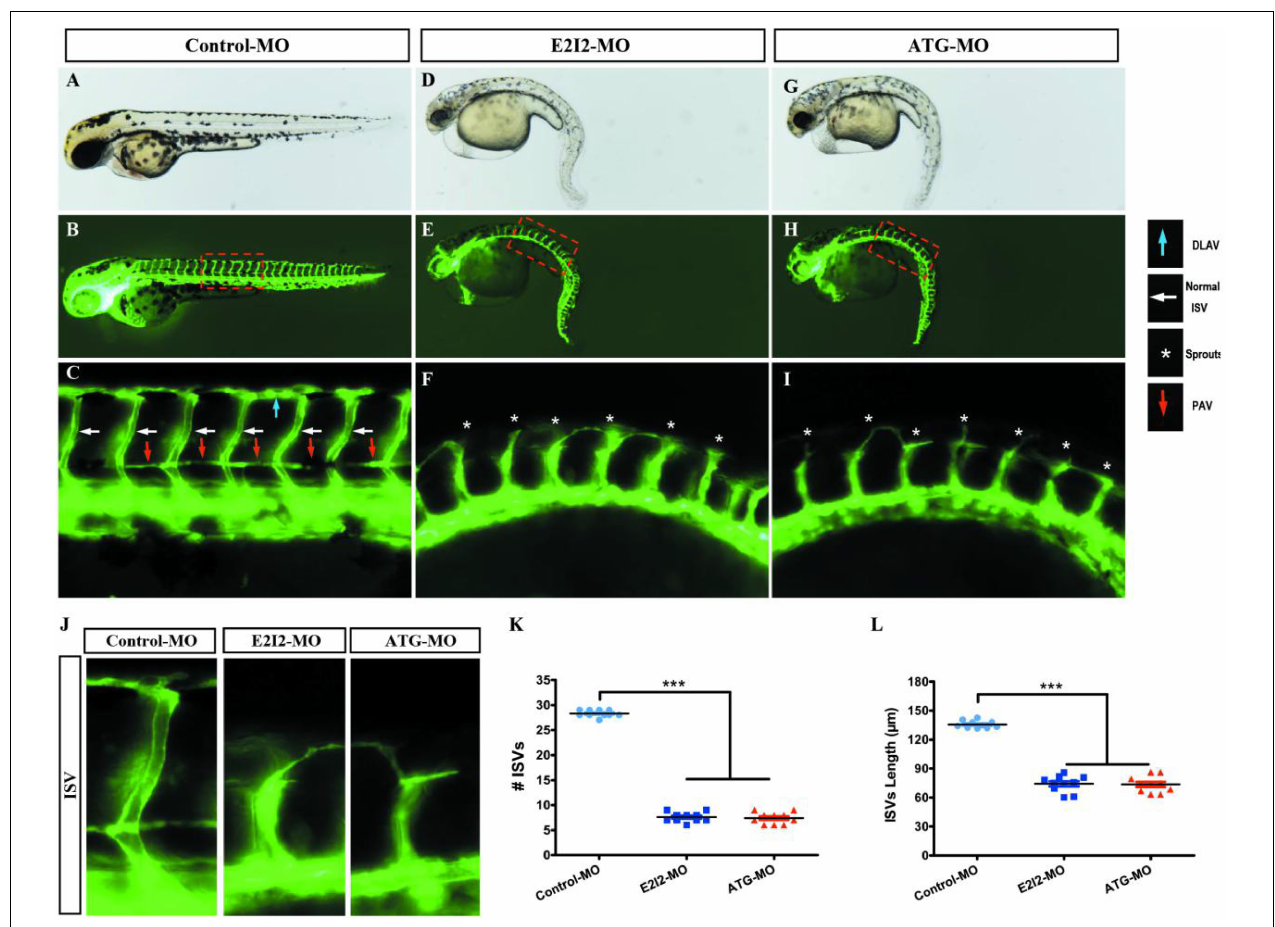
FIGURE 7 | Morpholino knockdown of acta2 causes vascular defects. (A–I) Representative bright field and fluorescent images of Tg (fli1a:EGFP)y1 embryos at 50-hpf. (B,C,E–H) Image of trunk regions taken at 50-hpf, with the vascular structures visualized by eGFP fluorescence and labeled ISV (intersegmental vessel) and DLAV (dorsal longitudinal anastomotic vessel) showed regular development in the embryo injected with control MO. Compared with control MO, embryos injected with acta2-MO present a lower number of incomplete ISVs and ectopic sprouts ( F,I , asterisk). In control embryos, the parachordal vessels (PAV) form normally ( C , red arrows). Compared with control, MO knockdown acta2 prevents the parachordal vessels (PAV) formation, the precursor to the lymphatic system. The boxed regions are shown at higher magnification in the bottom panels. (J–L) Quantification of the number of complete ISVs or mean length of ISVs shows a significantly decrease in acta2 morphants. Columns, mean; SEM ( n = 10; ANOVA) *** P < 0.0001. hpf, hours